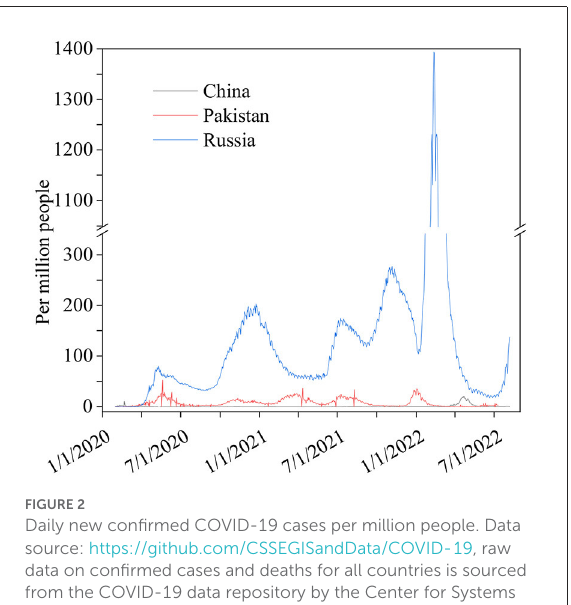
FIGURE2 Daily new confirmed COVID-19 cases per million people. Data source: https://github.com/CSSEGISandData/COVID-19, raw data on confirmed cases and deaths for all countries is sourced from the COVID-19 data repository by the Center for Systems Science and Engineering (CSSE) at Johns Hopkins University. January 27, 2020–August 20,